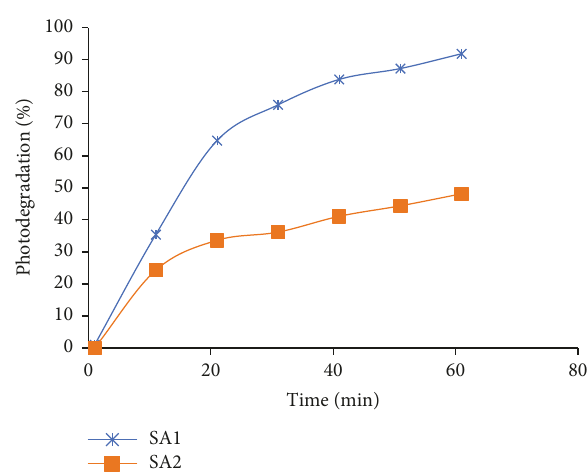
Figure 6: Variation of % of photodegradation versus time for various catalyst of ZnO (0.3 g) under a UV lamp.